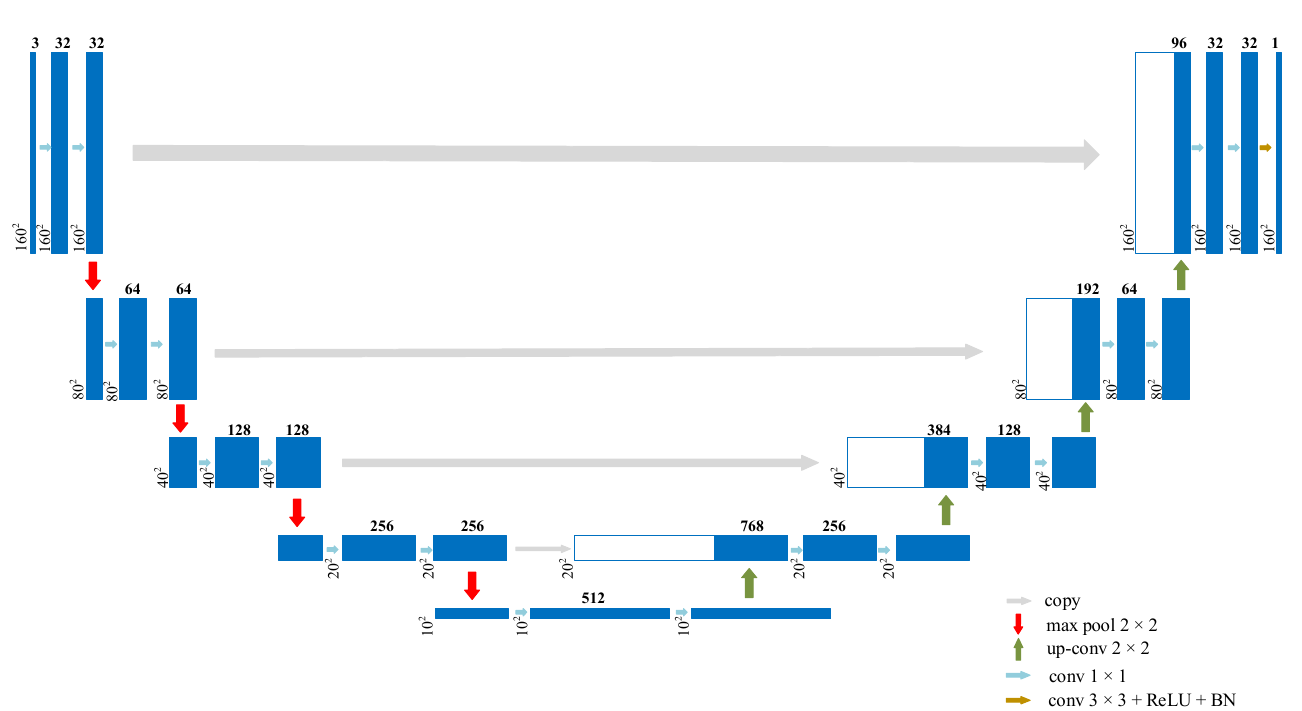
Figure 3. U-net architecture. Each blue box corresponds to a multi-channel feature map. The number of channels is indicated at the top of the box. X-y dimensions are provided on the lower-left edge of the box. The white box represents the replicated feature mapping. Arrows indicate different operations. ReLU indicates rectified linear units, and BN indicates a batch normalization layer.